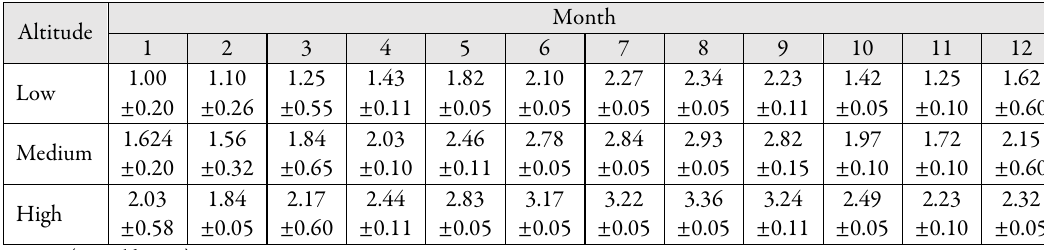
(% Yield mg/g) n= 3 P< 0.05.